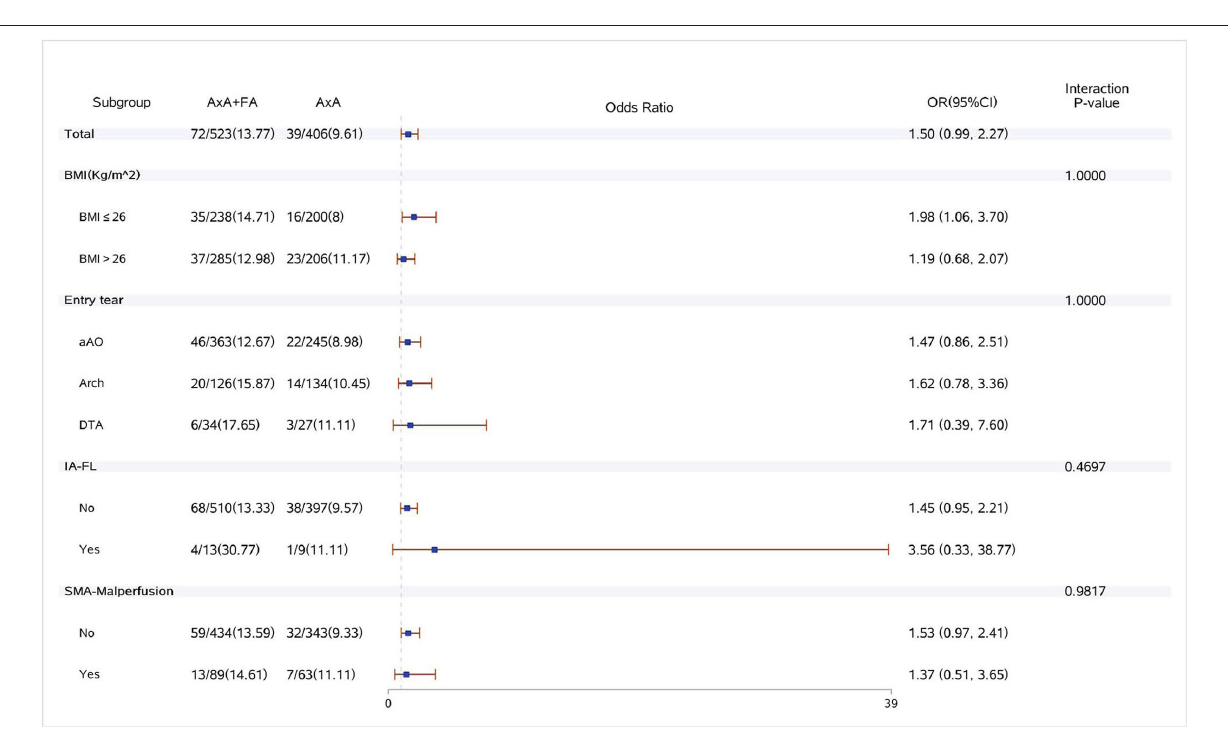
Frontiers in Cardiovascular Medicine |